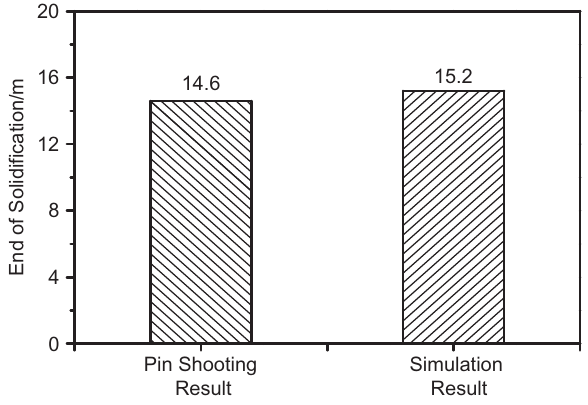
Figure 3: Comparison of solidifying end between pin shooting results and simulated